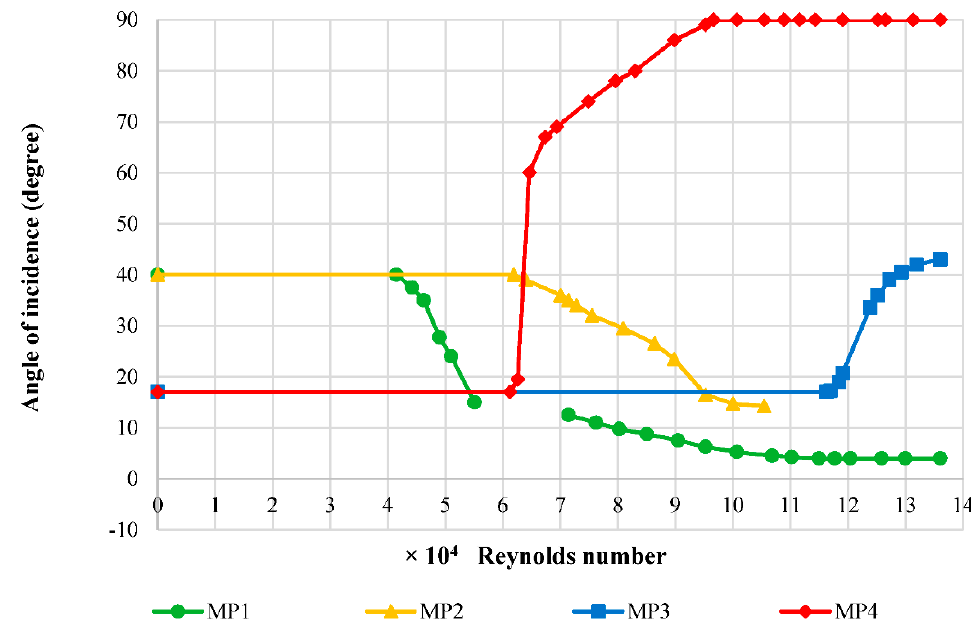
Figure 6. Effect of pivot point location on NACA 0012.